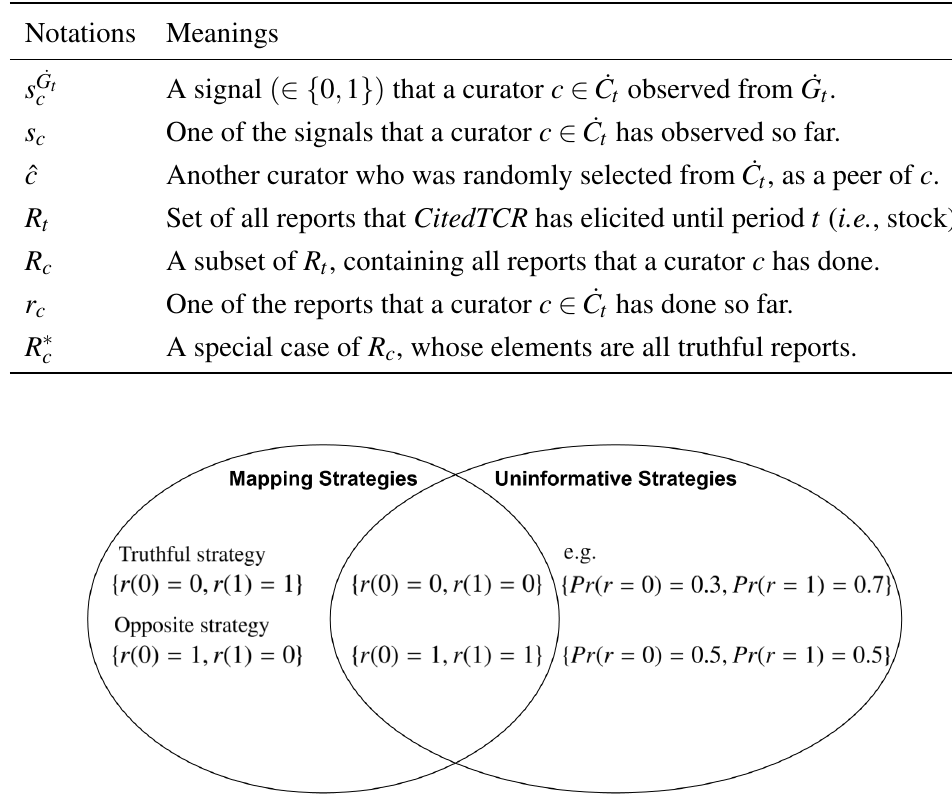
Table 2. Notations for DG13 in CitedTCR